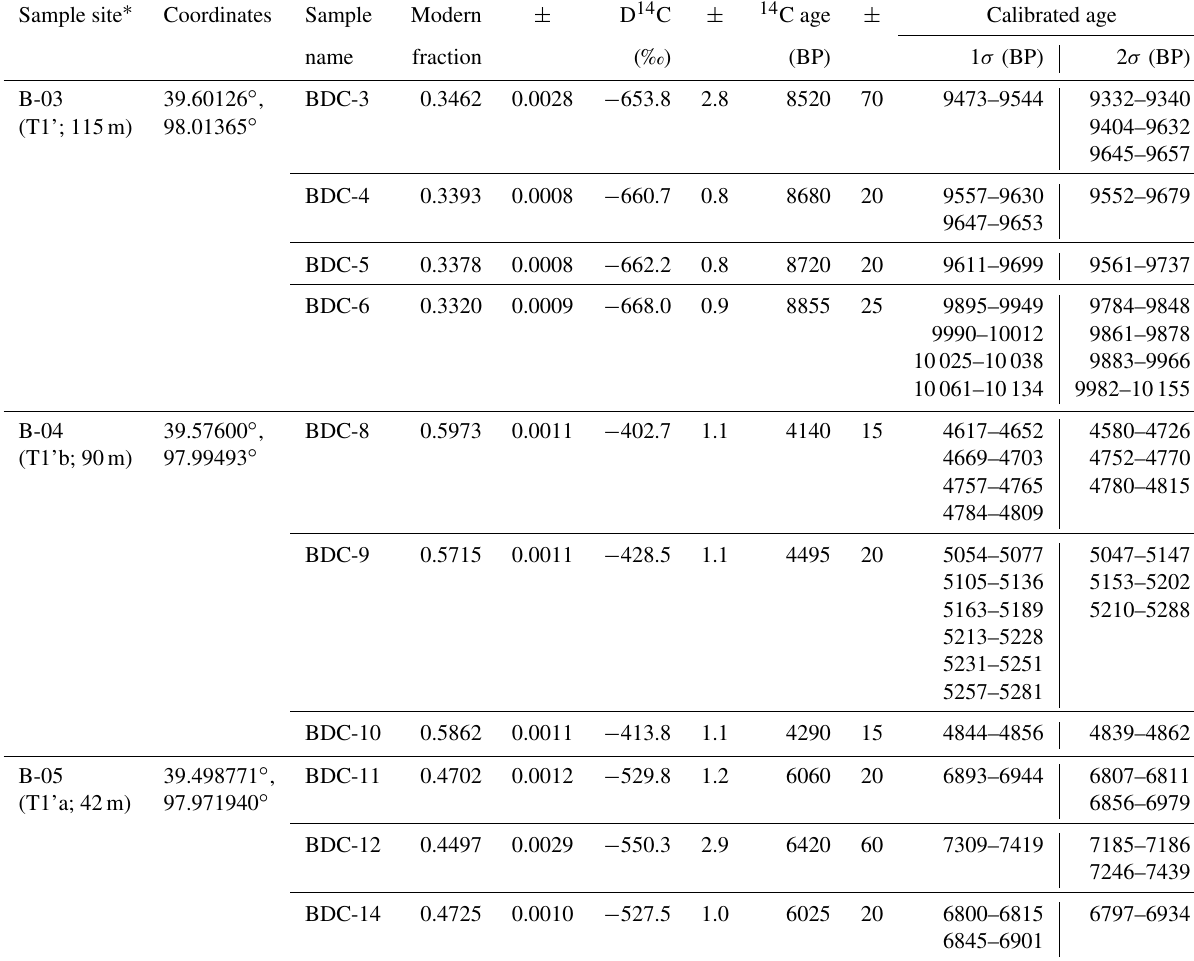
Table 2. 14 C age of Beida River terraces.